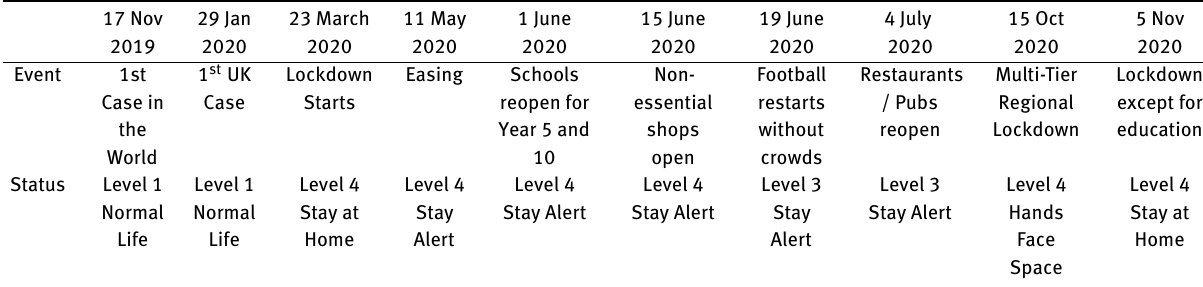
Table 1: Lockdown status of